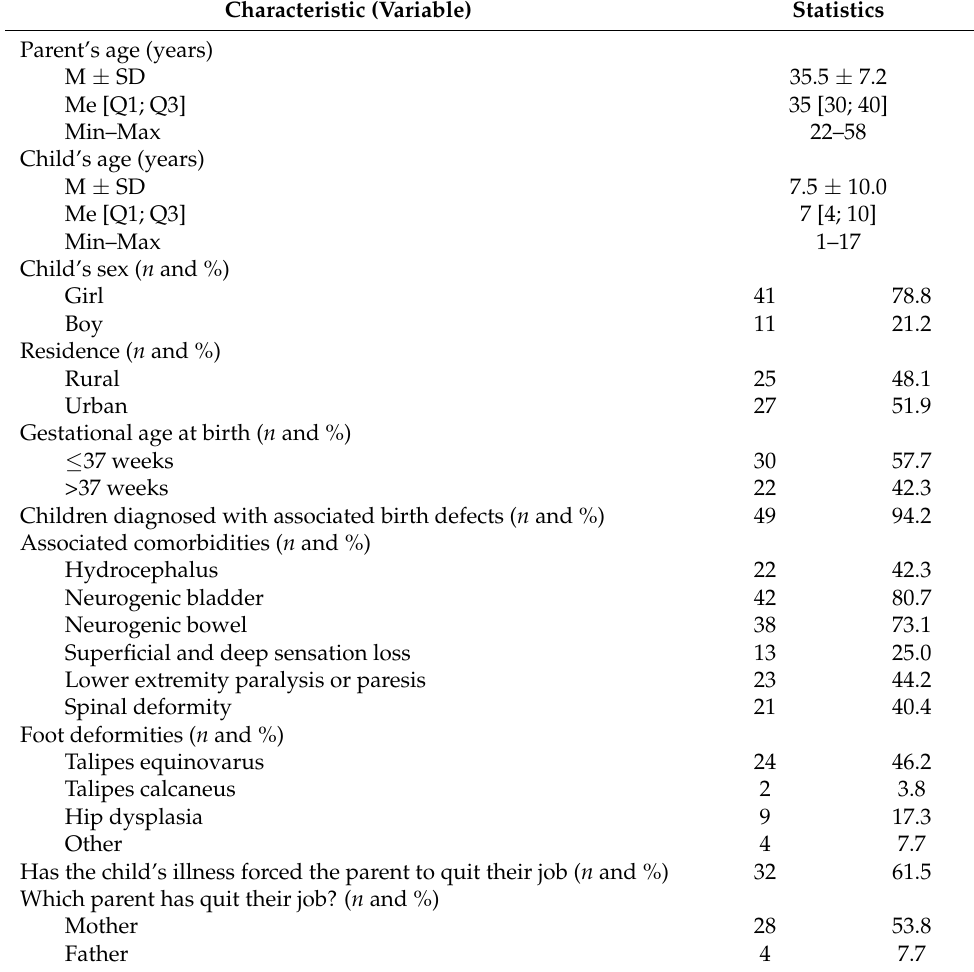
Table 1. Characteristics of the parents and their